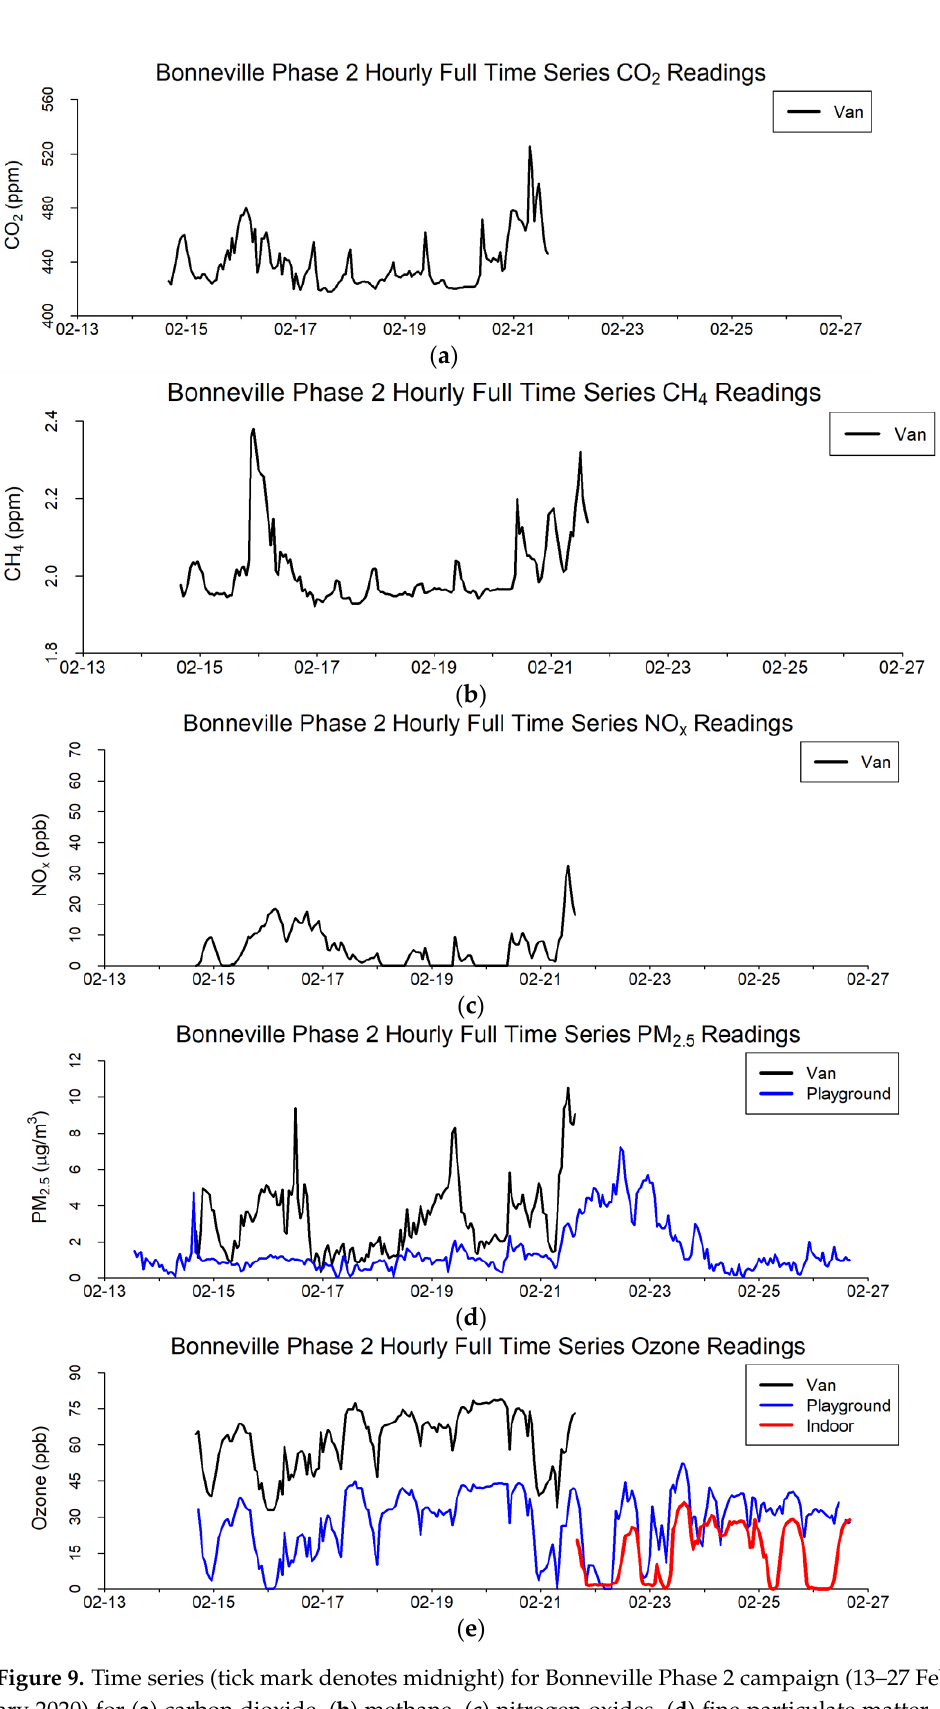
Figure 9. Time series (tick mark denotes midnight) for Bonneville Phase 2 campaign (13–27 February 2020) for ( a ) carbon dioxide, ( b ) methane, ( c ) nitrogen oxides, ( d ) fine particulate matter, and ( e ) ozone.